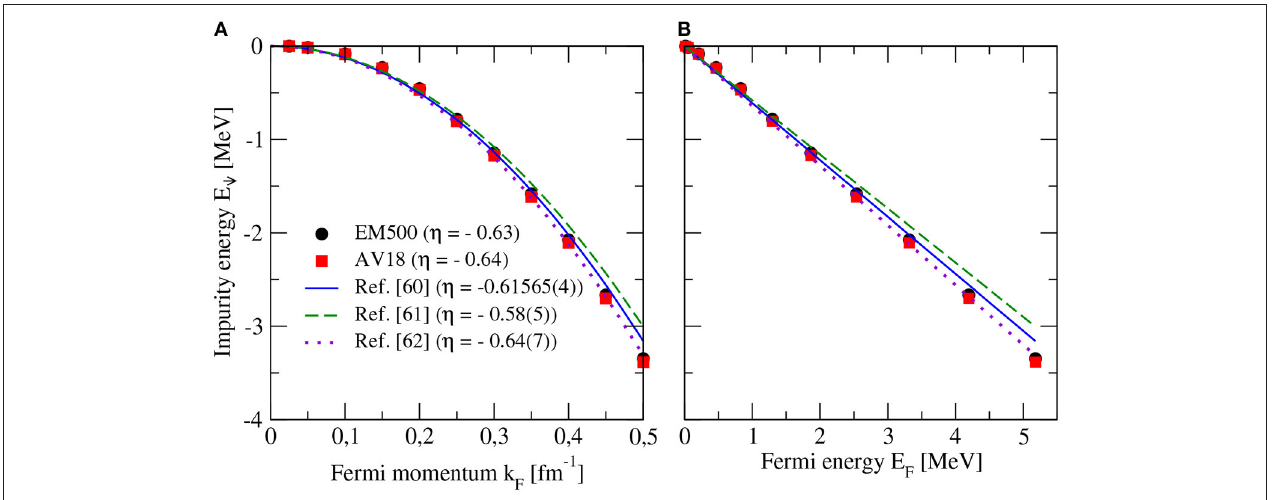
FIGURE 4 | Energy of a ↓ neutron impurity with zero momentum as a function of the Fermi momentum (A) and of the Fermi energy (B) of the free gas of ↑ neutrons. The results obtained with the EM500 interaction (full circles) and the AV18 potential (full squares) are compared with those obtained when using the values of the proportionality constant η derived in the QMC calculation of reference [ 60] (solid line) and experimentally in references [61, 62] (dashed and dotted lines).